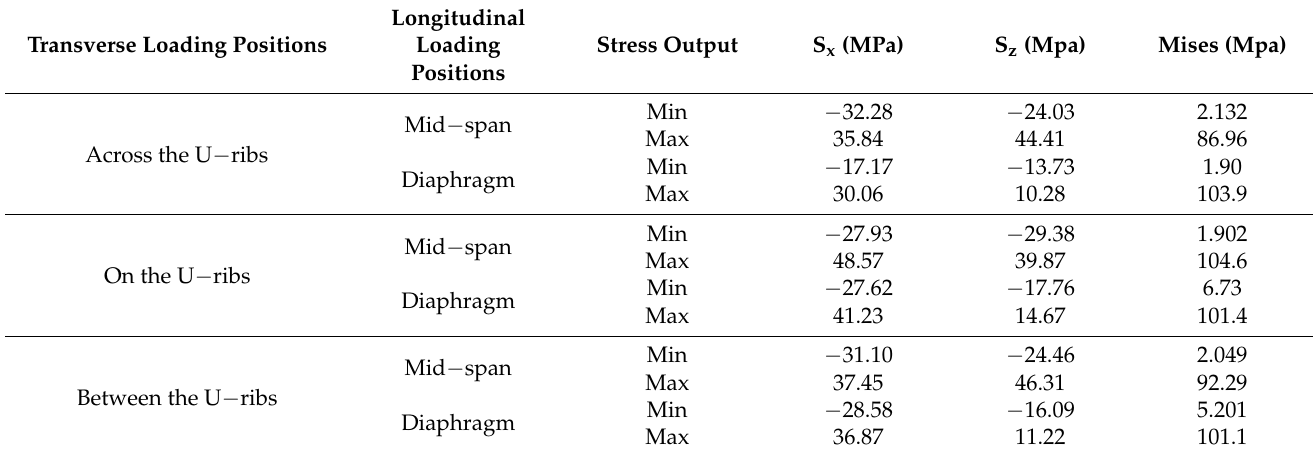
Table 3. Stress results of FE model.